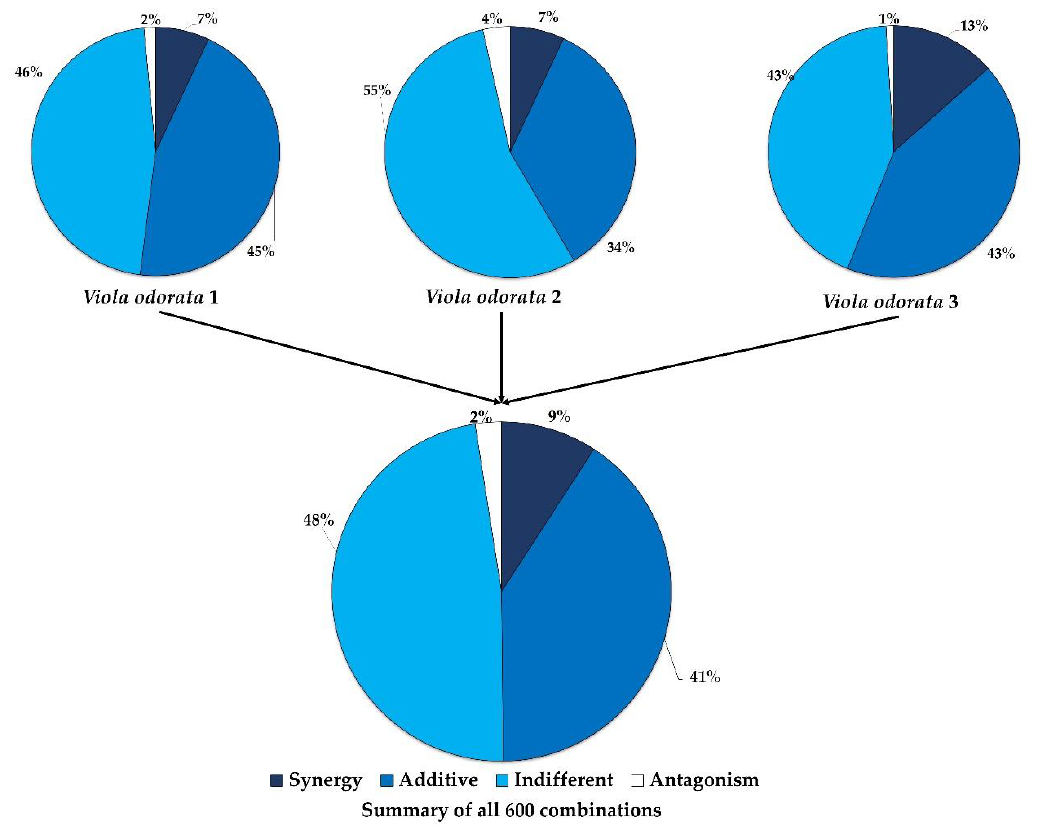
Figure 1. Summary of interactive profile of combinations.